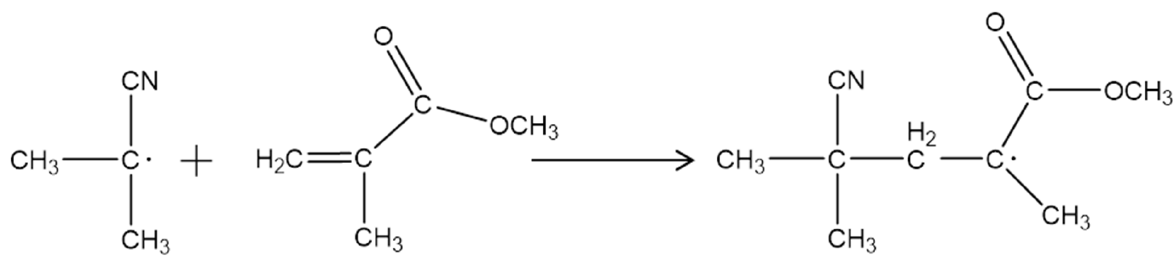
Figure 8. Free radical formation.